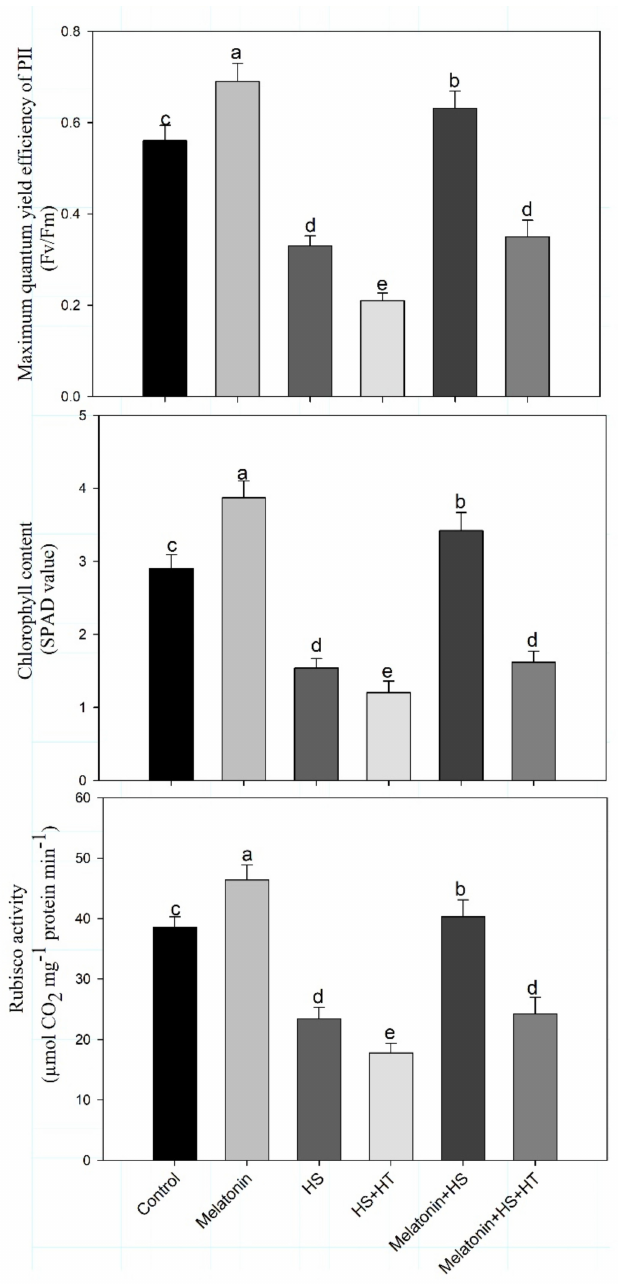
Figure 3. Maximum quantum yield efficiency of PS II, chlorophyll content and Rubisco activity of wheat ( Triticum aestivum L. var. WH 542) leaves at 30 days after sowing (DAS). Plants were treated with melatonin (100 µ M) and/or HT (100 µ M) in the presence (40 ◦ C) or absence (25 ◦ C) of heat stress. Data are presented as means ± SE ( n = 4). Data followed by the same letter are not significantly different by LSD test at p < 0.05. HS, heat stress; HT;